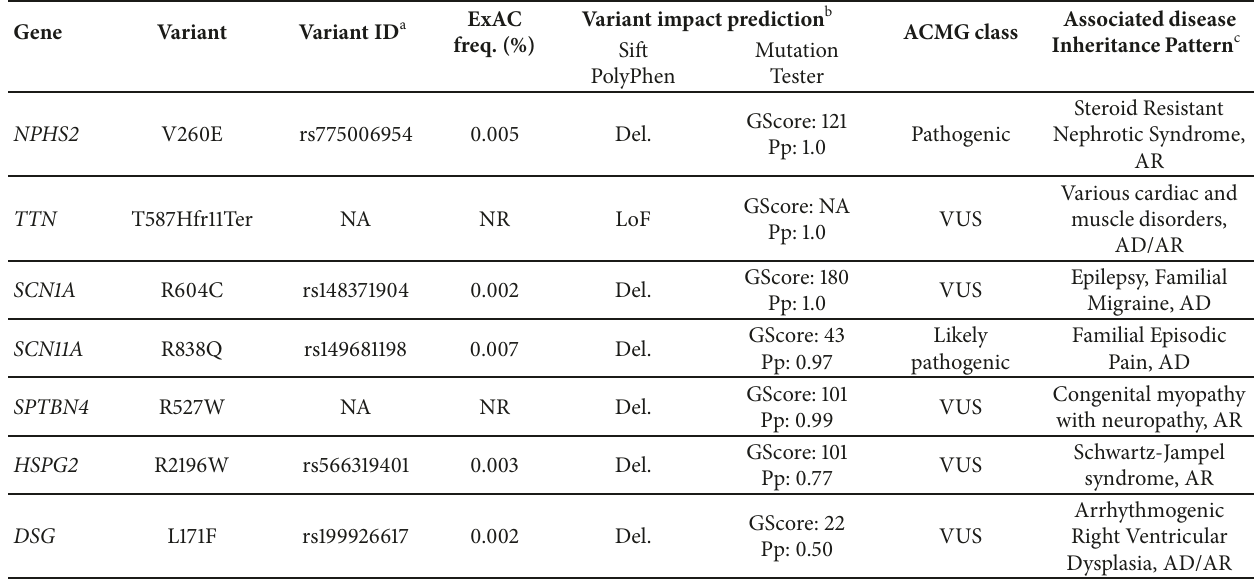
Table 1: Exome sequencing results. Findings are presented by the degree of pathogenicity predicted by various methods.